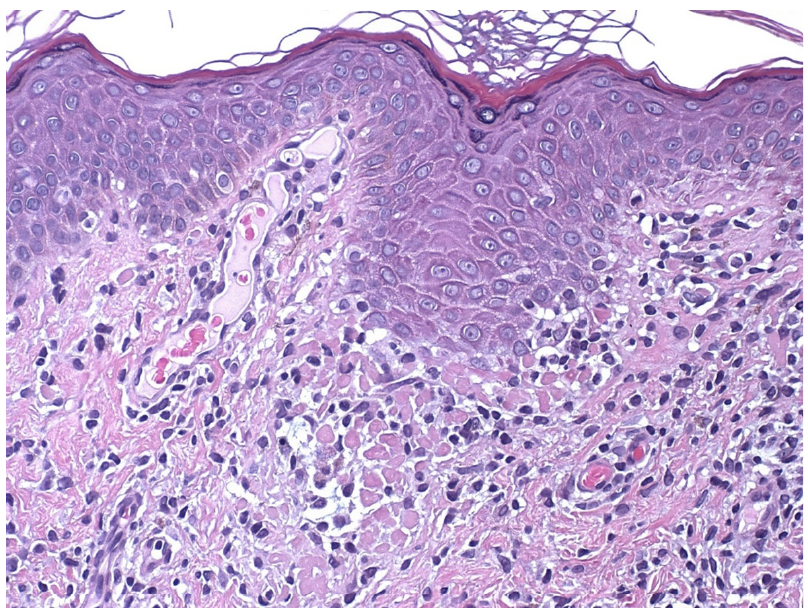
Figure 6. Massive necrosis/apoptosis of keratinocytes with “decapitation” of the base of an epider- mal ridge.